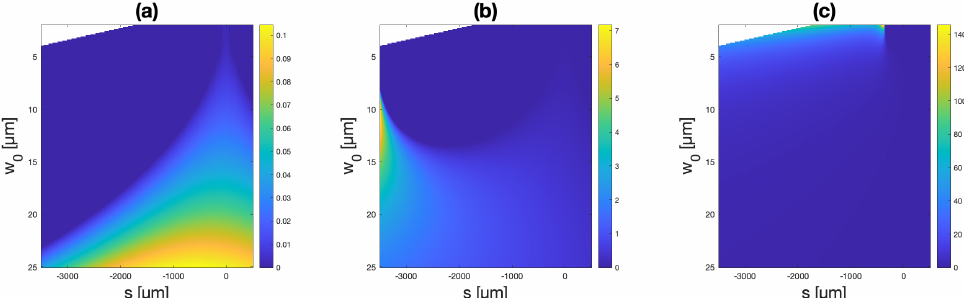
Figure 7. Relative focal shift simulation results for 300 µ m membranes and deflections of ( a ) 100 nm ( b ) 1 µ m, and ( c ) 10 µ m. The colormaps represent focal shifts normalized by the Rayleigh range of the incident